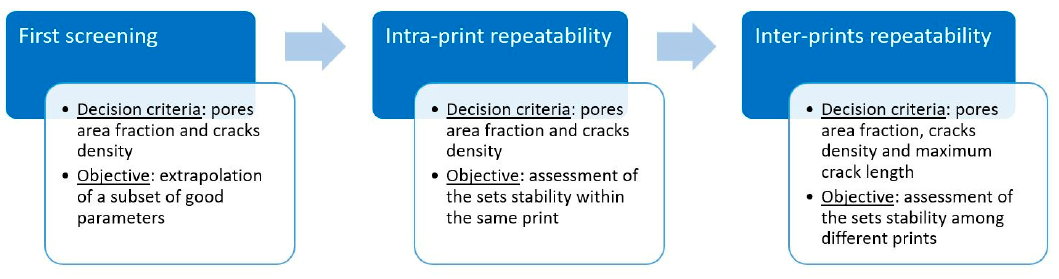
Figure 16. Logical path followed for the L-PBF process optimization on René 80.